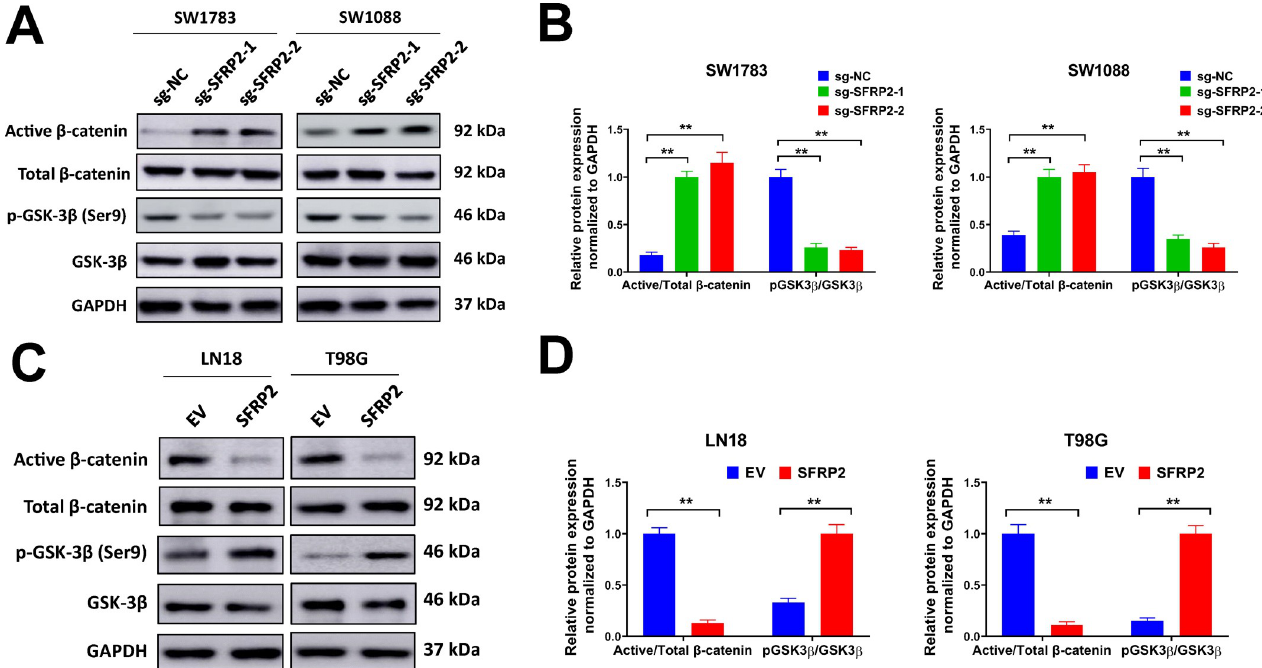
Fig 5. SFRP2 regulates Wnt/ β -catenin activation in glioma cells. A-B, SW1783 and SW1088 cells were introduced with sg-SFRP2-1, sg-SFRP2-2 or sg-NC lentiviral particles, then protein expression of indicated genes was evaluated by western blot (A). Relative protein expression compared with GAPDH (B) was shown. C-D, LN18 and T98G cells were infected with SFRP2 expression lentivirus or EV control, then protein expression of indicated genes was evaluated by western blot (C). Relative protein expression compared with GAPDH (D) was shown. �� P < 0.001.